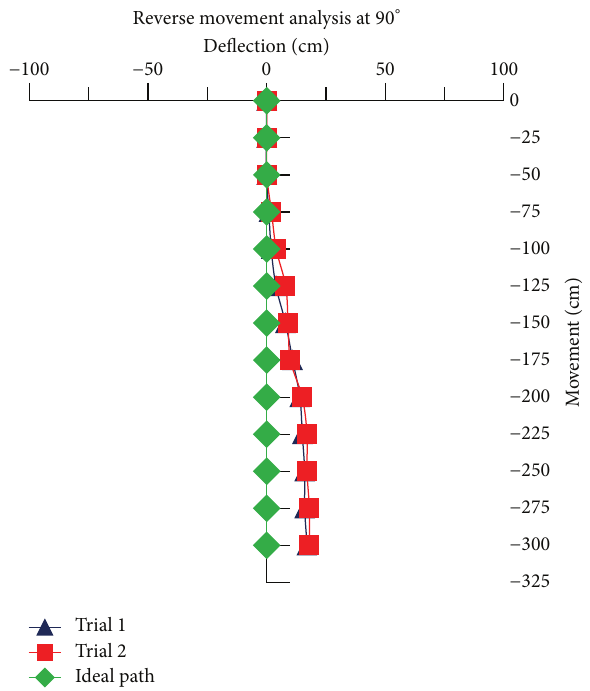
Figure 20: Reverse movement versus deflections at 𝜃 = 90 ∘ .